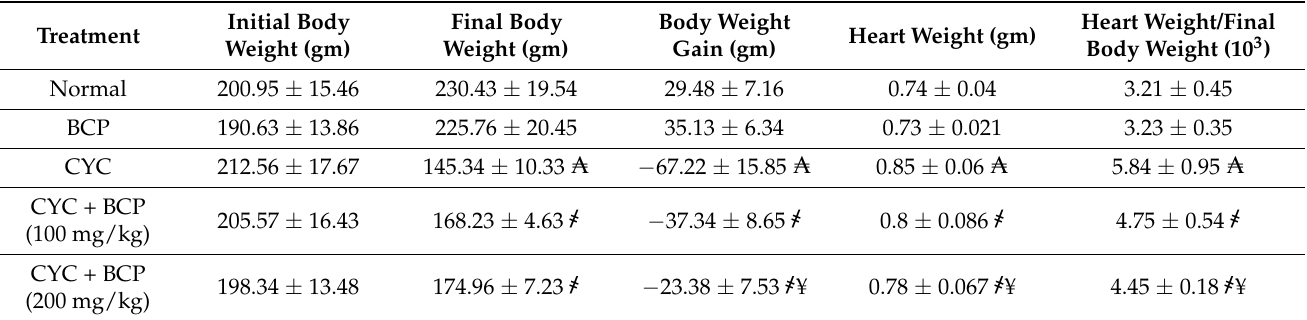
indicates a statistically significant difference from normal group;